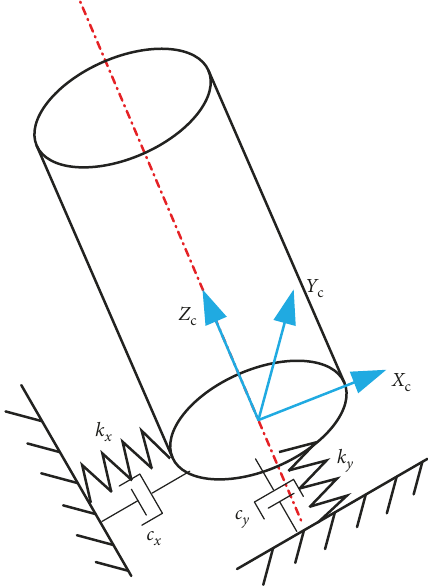
Figure 2: The two-degree-of-freedom vibration model of the cutter.